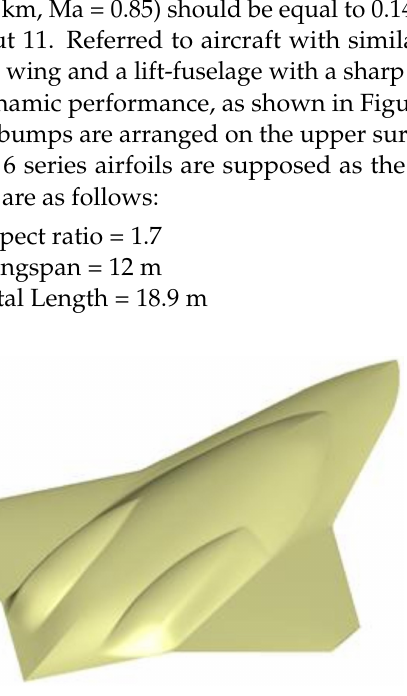
Figure 8. The model of initial